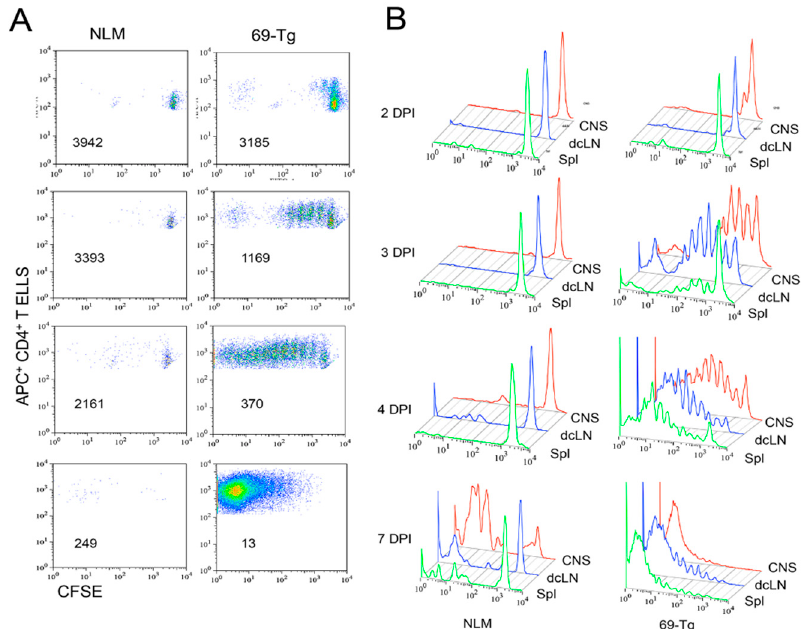
Figure 4. Comparison of the initial proliferative responses of TCR-Tg and control CD4 + T cells in the CNS and periphery after TMEV infection. Negatively isolated CD4 + T cells from naive TCR-Tg and control SJL mice were labeled with CFSE and transferred intravenously into normal SJL mice. The recipient mice were infected intracerebrally with 1 × 10 6 PFU TMEV. Cells from the recipients from the CNS, deep cervical lymph nodes (dcLN), and spleens were analyzed at 2, 3, 4, and 7 dpi for their cellular divisions using flow cytometry after staining with APC-labeled anti-CD4 + T cells in conjunction with CSFE intensity. ( A ) The division patterns of CFSE + CD4 + T cells in the spinal cords of the mice receiving either control or TCR-Tg CD4 + T cells. The number in each flow cytogram represents the mean CFSE intensity of the CD4 + T cells. ( B ) Comparison of the division patterns of the transferred CD4 + T cells in the CNS, dcLN, and spleen.